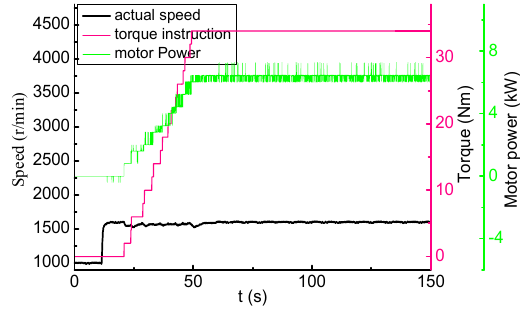
Figure 17. Warm-up test process.